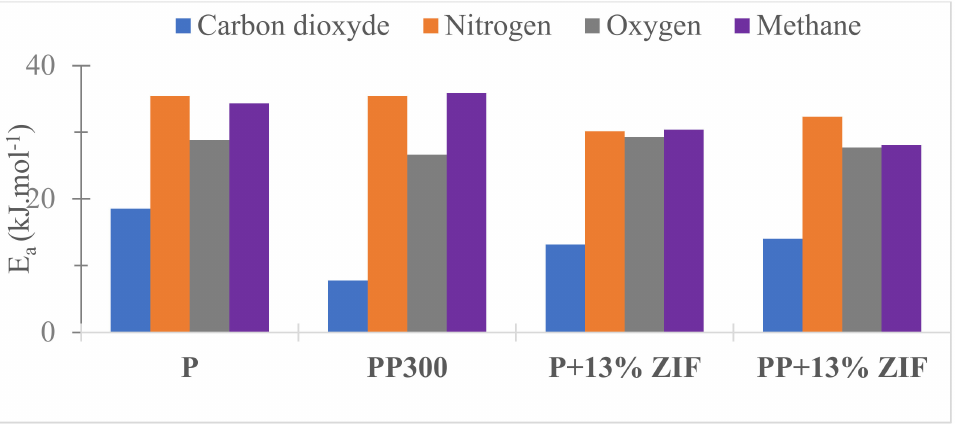
Figure 13. Activation energy of CO 2 , CH 4 , O 2 and N 2 for neat Pebax (P), PP300, P + 13% ZIF-8 and PP + 13%